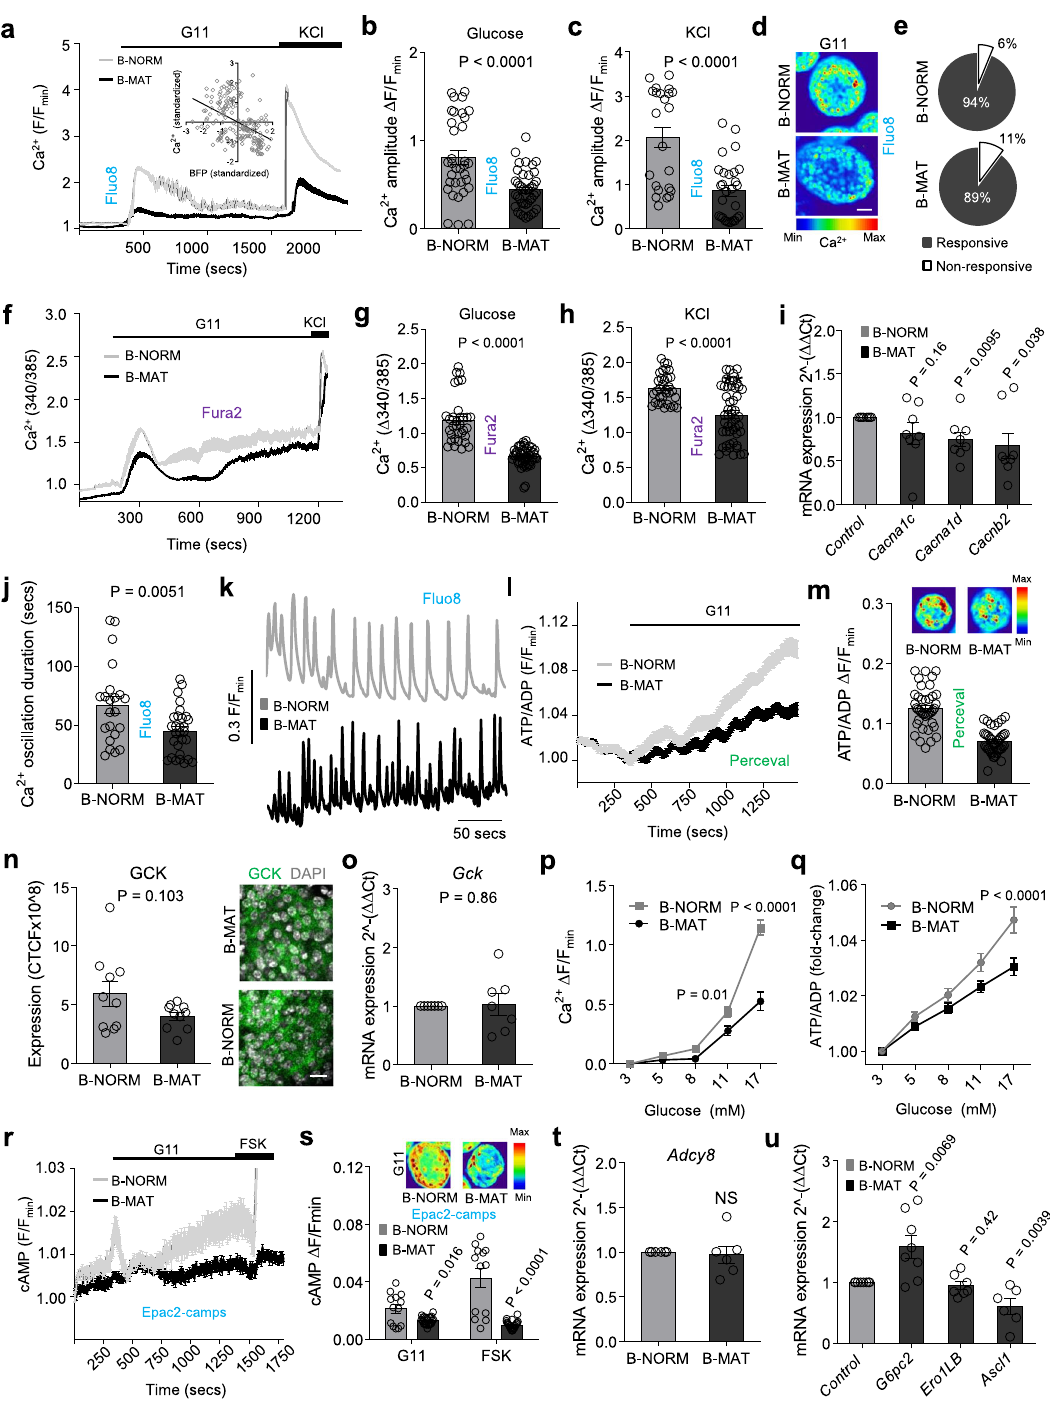
insulin secretion remained signi fi cantly decreased in B-MAT islets (Supplementary Fig. 5g). Super-resolution imaging revealed no differences in insulin granule density at the membrane (Fig. 4i), in line with unchanged expression of mRNA for the exocytotic machinery (e.g., Stx1a , Snap25 and Vamp2 ) (Fig. 4j). Implying the presence of normal insulin gene regulation, Ins1 and Ins2 mRNA levels were unaffected (Fig. 4k, l). The loss of incretin-responsiveness was surprising given that gut- and islet- derived GLP1 38,39 potently upregulates the sensitivity of insulin granules for exocytosis 38 . Further analyses showed a